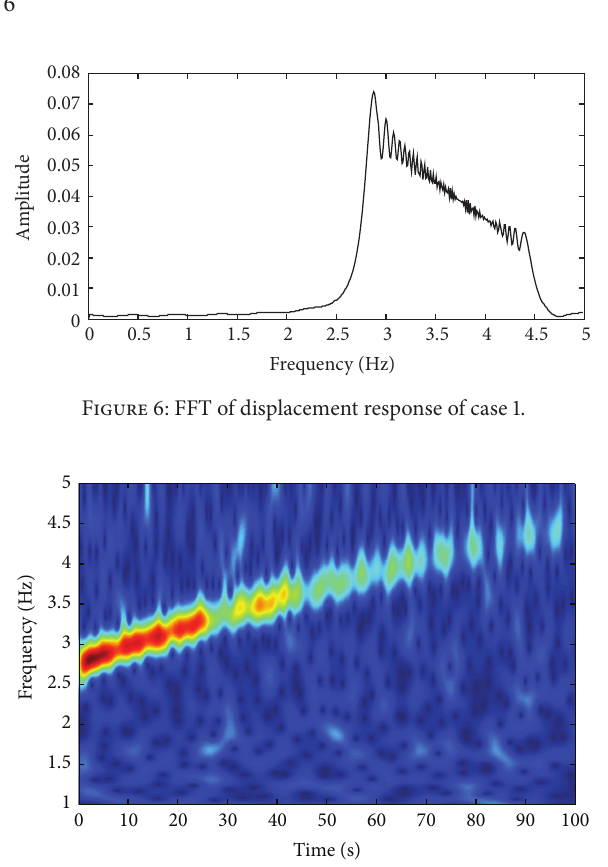
Figure 7: CWT scalogram of displacement response of case 1.